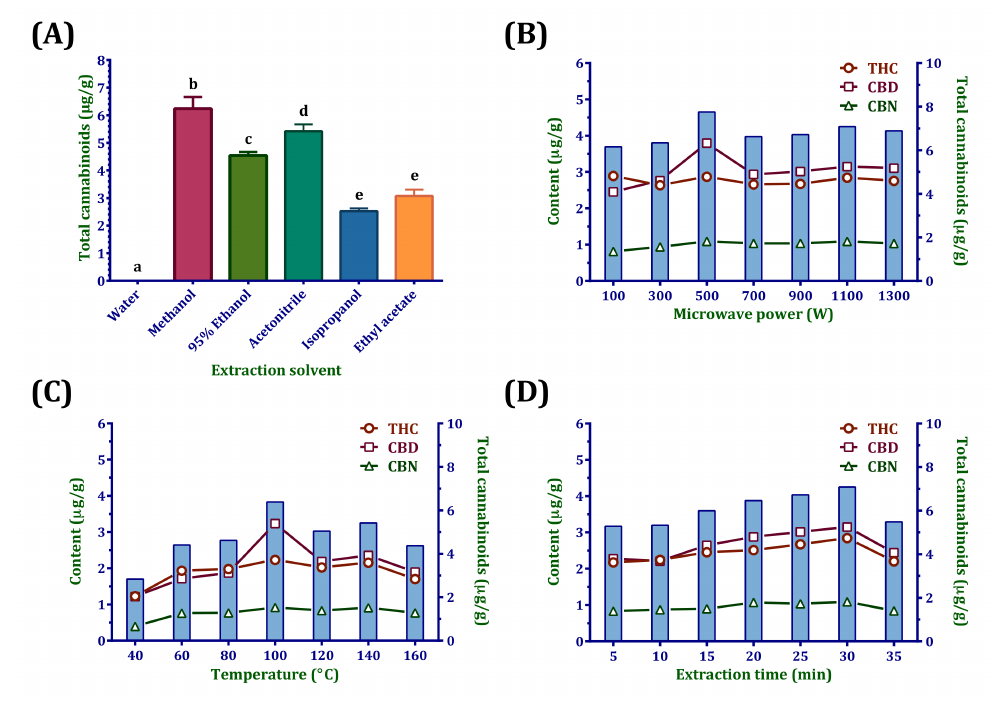
Figure 1. Effect of ( A ) extraction solvent, ( B ) microwave power, ( C ) temperature, and ( D ) extraction time on the yields of cannabinoids. Different letters (a, b, c, d, e) indicate a significant difference ( p <